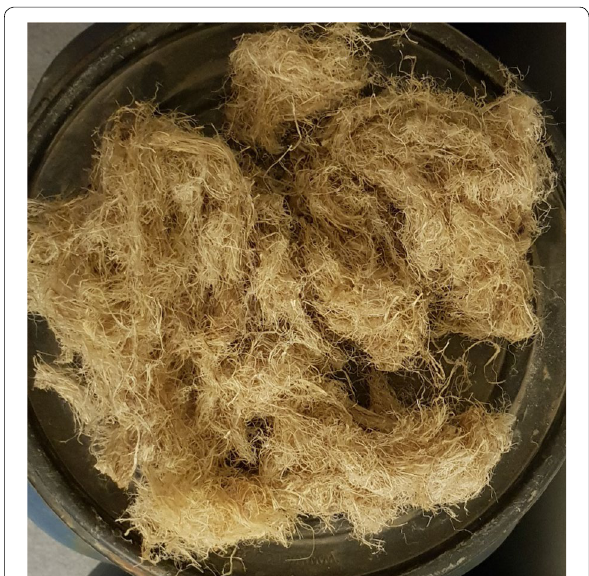
Fig. 1 Hemp fibers in their initial